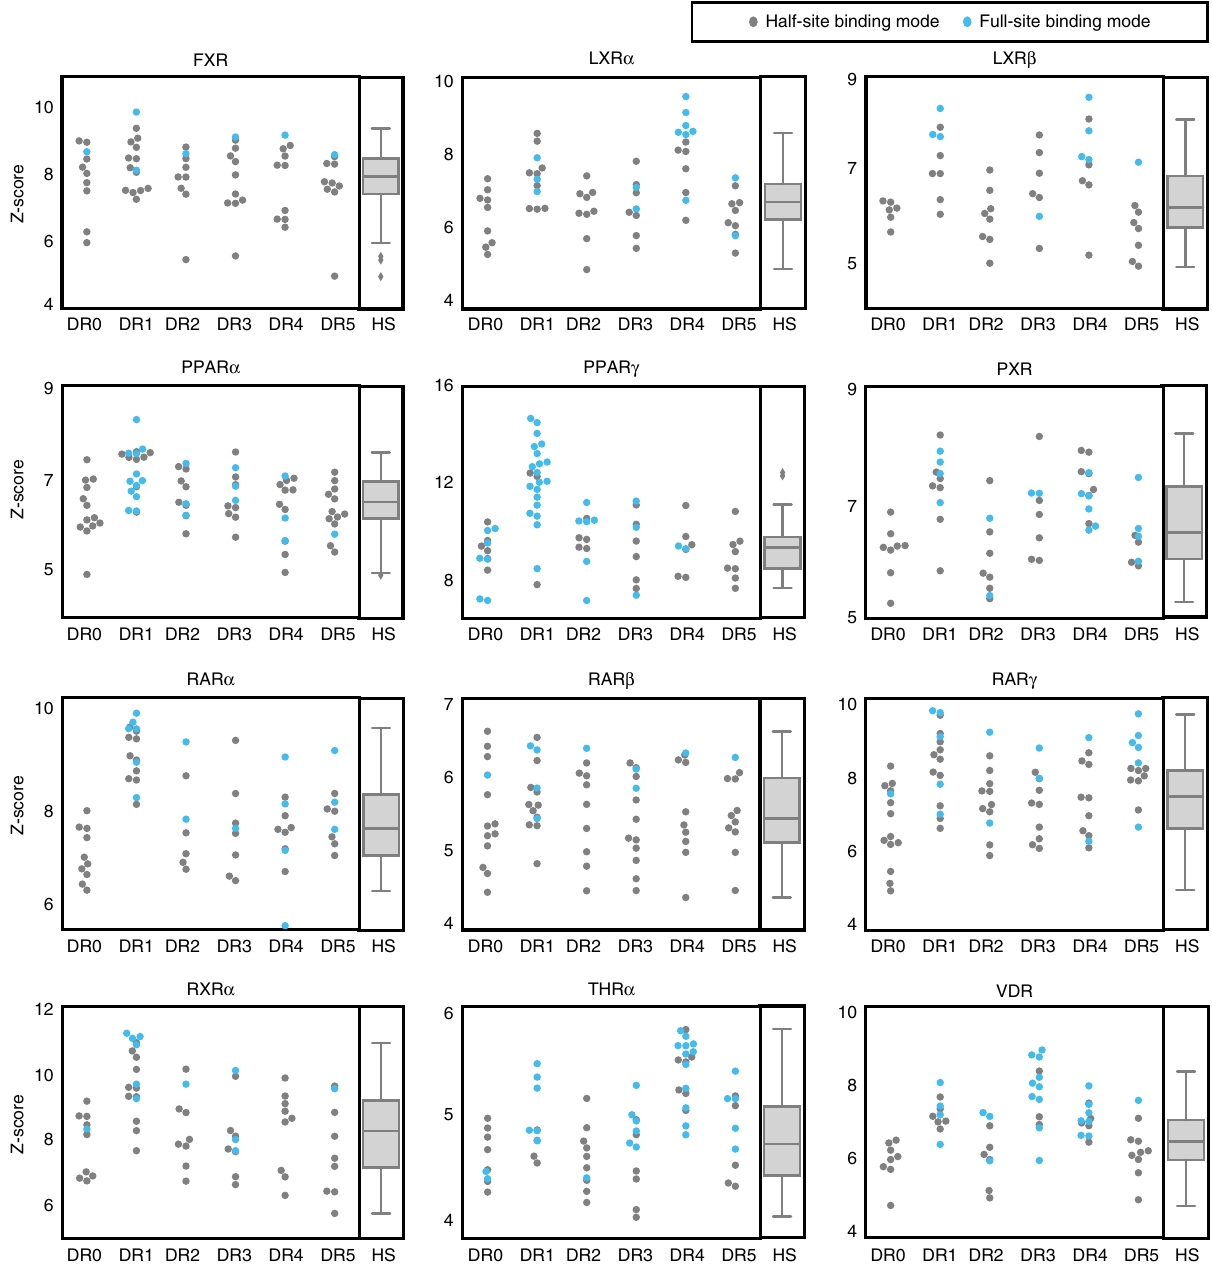
Fig. 4 NR-binding af fi nity and mode for sequences at each DR spacer length. At each spacer length, the replicate averaged z-score of the highest scoring SNV for each seed sequence is shown; seed sequences with z-score < 3 are not represented. Colors indicate binding mode for each seed sequence. For each NR, box plots show the z-score distributions for all sites that are bound in half-site modes across all direct repeat spacer lengths (the aggregate of all gray dots). Center line: median; box limits: upper and lower quartiles; whiskers: last datum within 1.5x interquartile range. Source data are provided as